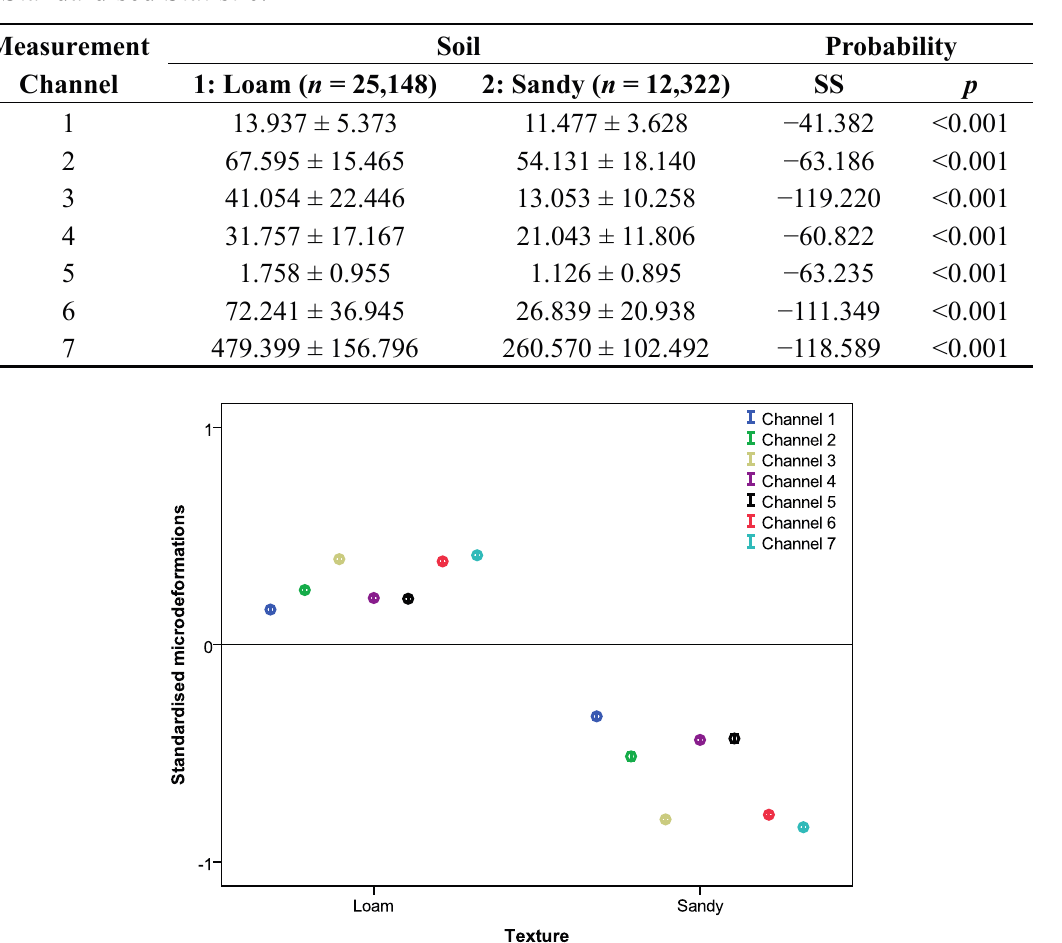
Figure 7. 95% confidence intervals of all micro-strains standardised according to soil